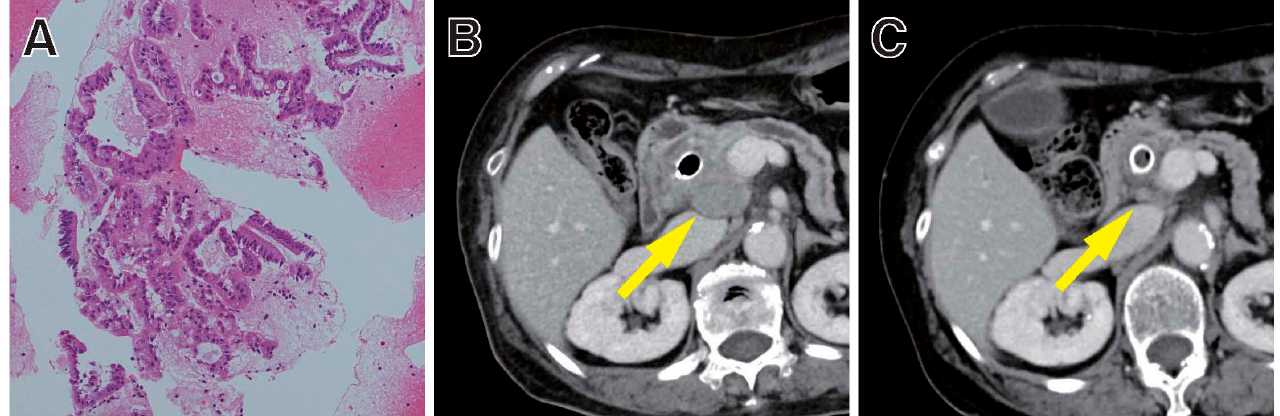
Figure 2. Clinical response to pembrolizumab in a PC patient with MSI-H. ( A ) Tissue sample from PC. MSI analysis using a FFPE sample obtained by EUS-FNB showed MSI-H; ( B ) The pancreatic head cancer was refractory to the previously administered systemic chemotherapy, with disease progression; ( C ) A durable and confirmed partial response was achieved. Substantial shrinkage in the size of the pancreatic head mass was noted even from early (by week 8, as shown; arrowed) in the course of therapy.